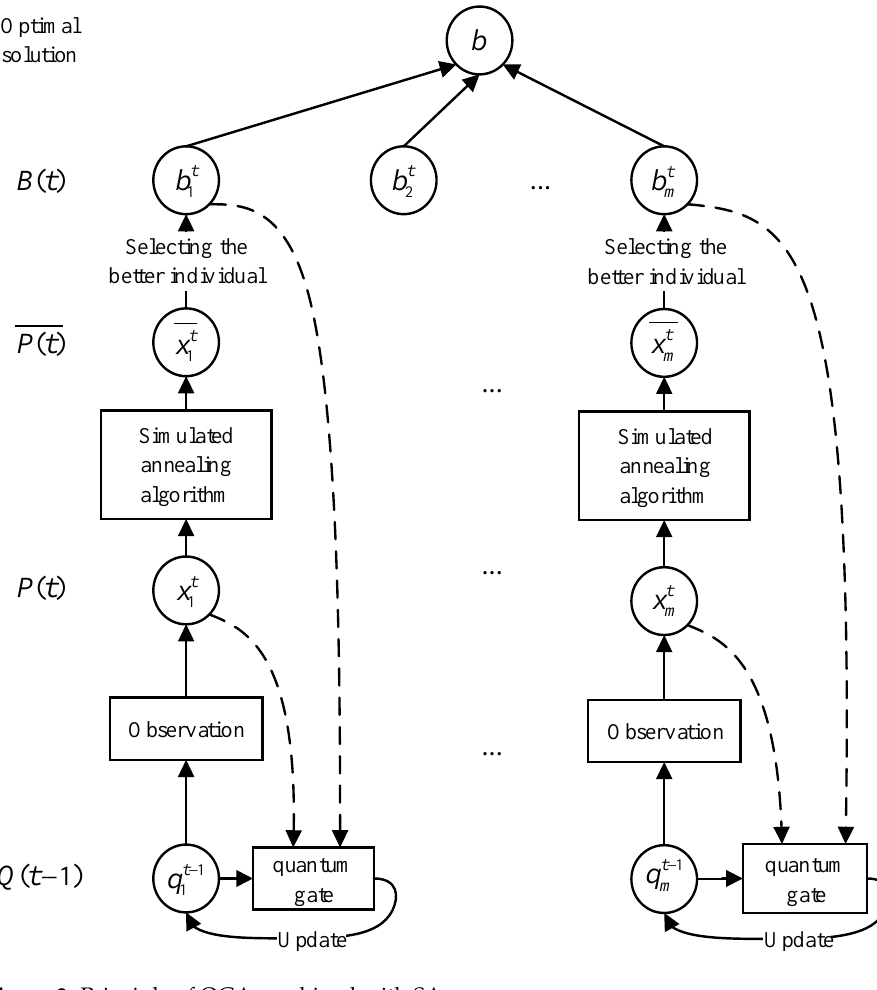
Figure 3. Principle of QGA combined with SA.